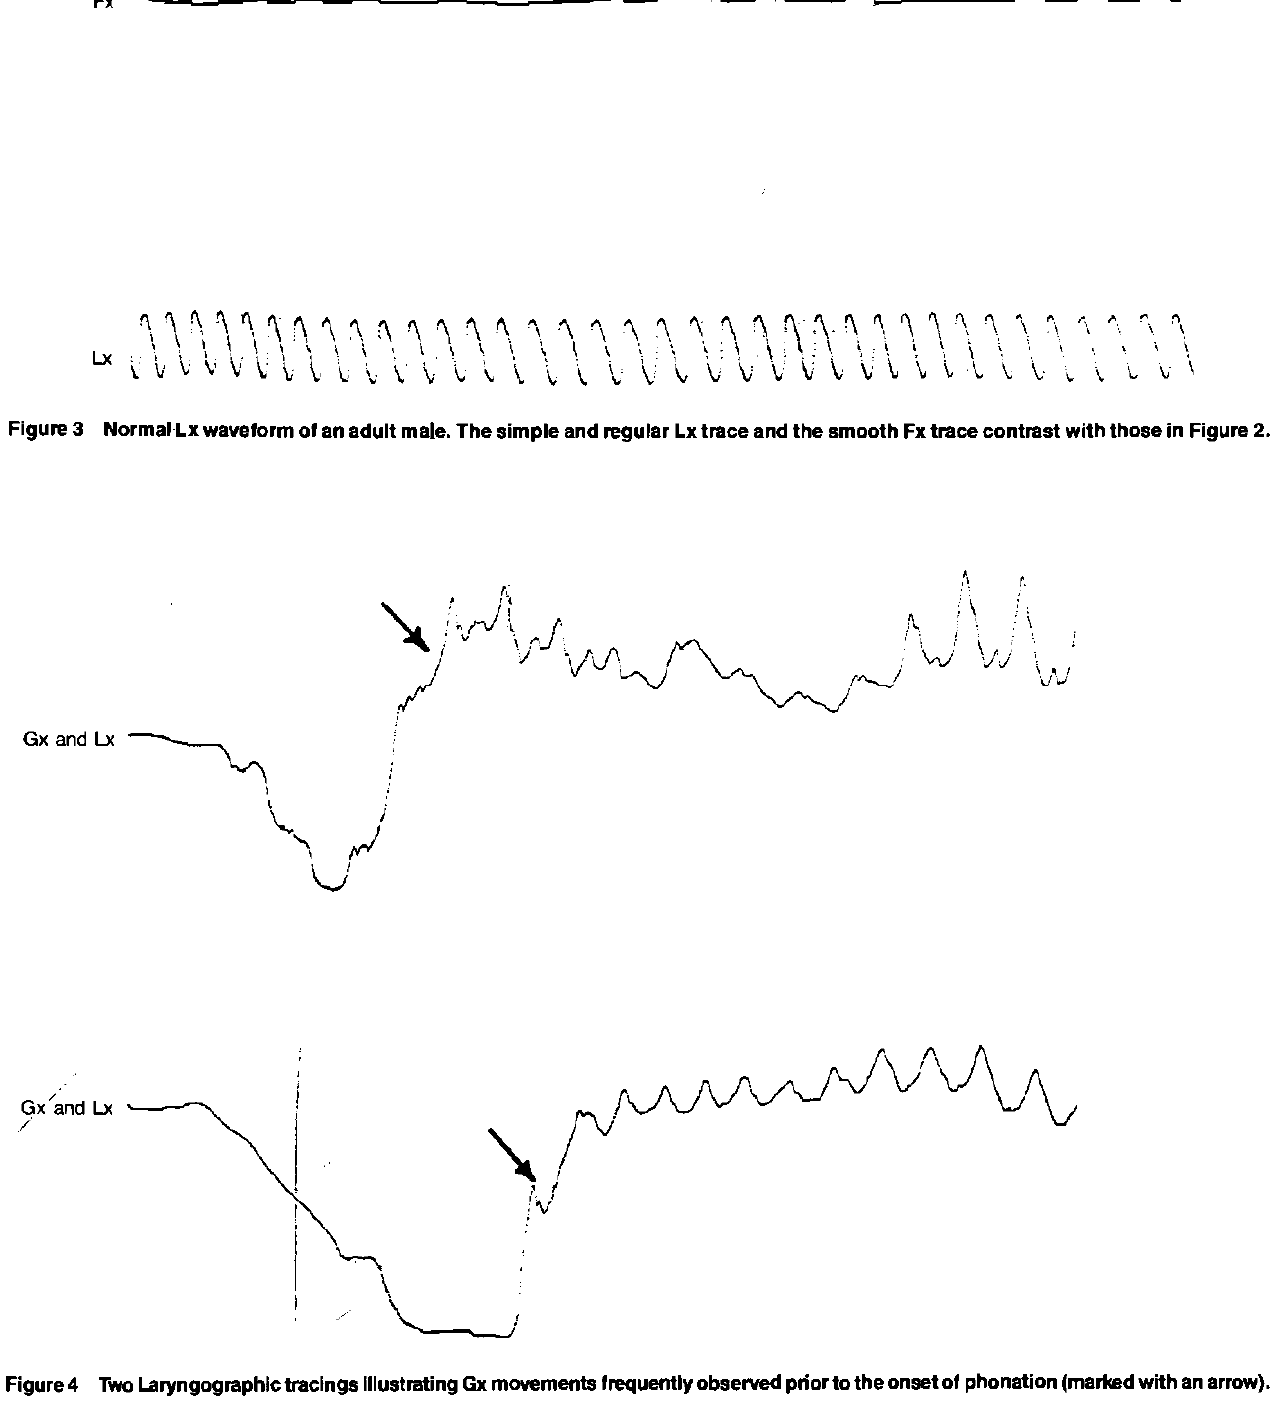
Figure 3 Normal Lx waveform of an adult male. The simple and regular Lx trace and the smooth Fx trace contrast with those in Figure 2.